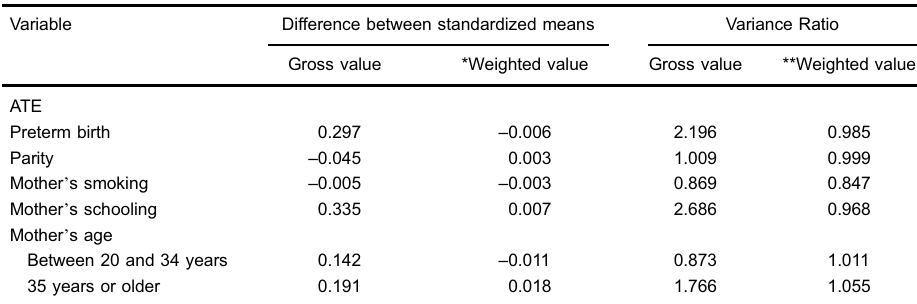
Table 3. Propensity score weighting of study variables.